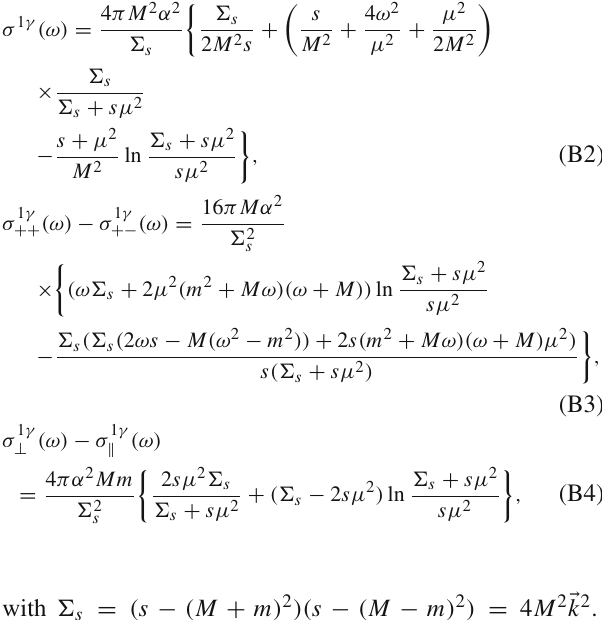
described by 2 Mandelstam variables, e.g., Q 2 = − ( k − k (cid:2) ) 2 —the squared momentum transfer, and s = ( p + k ) 2 = M 2 + 2 M ω + m 2 —the squared energy in the lepton–proton c.m. reference